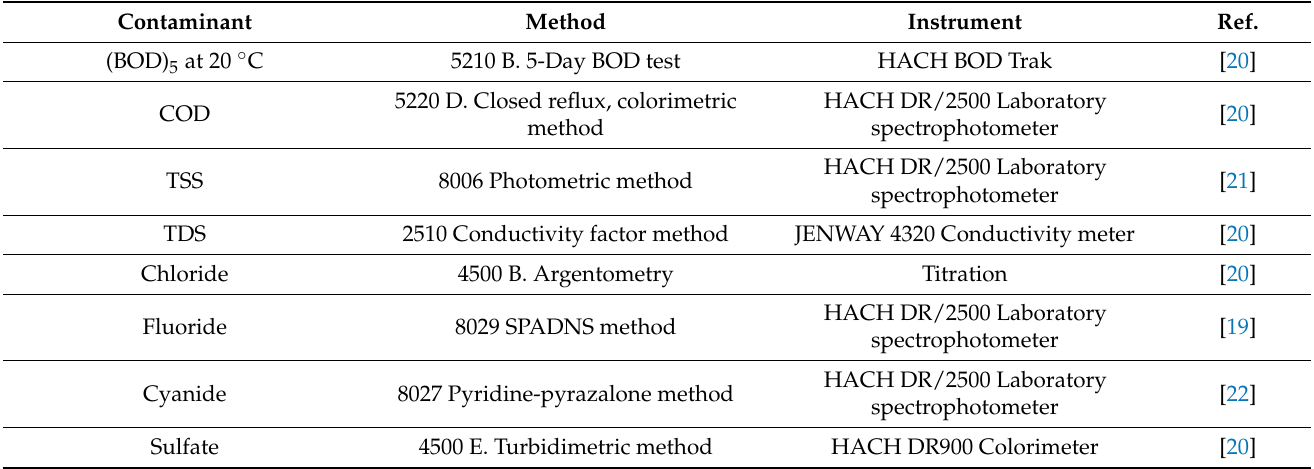
Table 1. Analytical techniques and instrumental details used in the study to detect different wastewater contaminants and heavy metals.